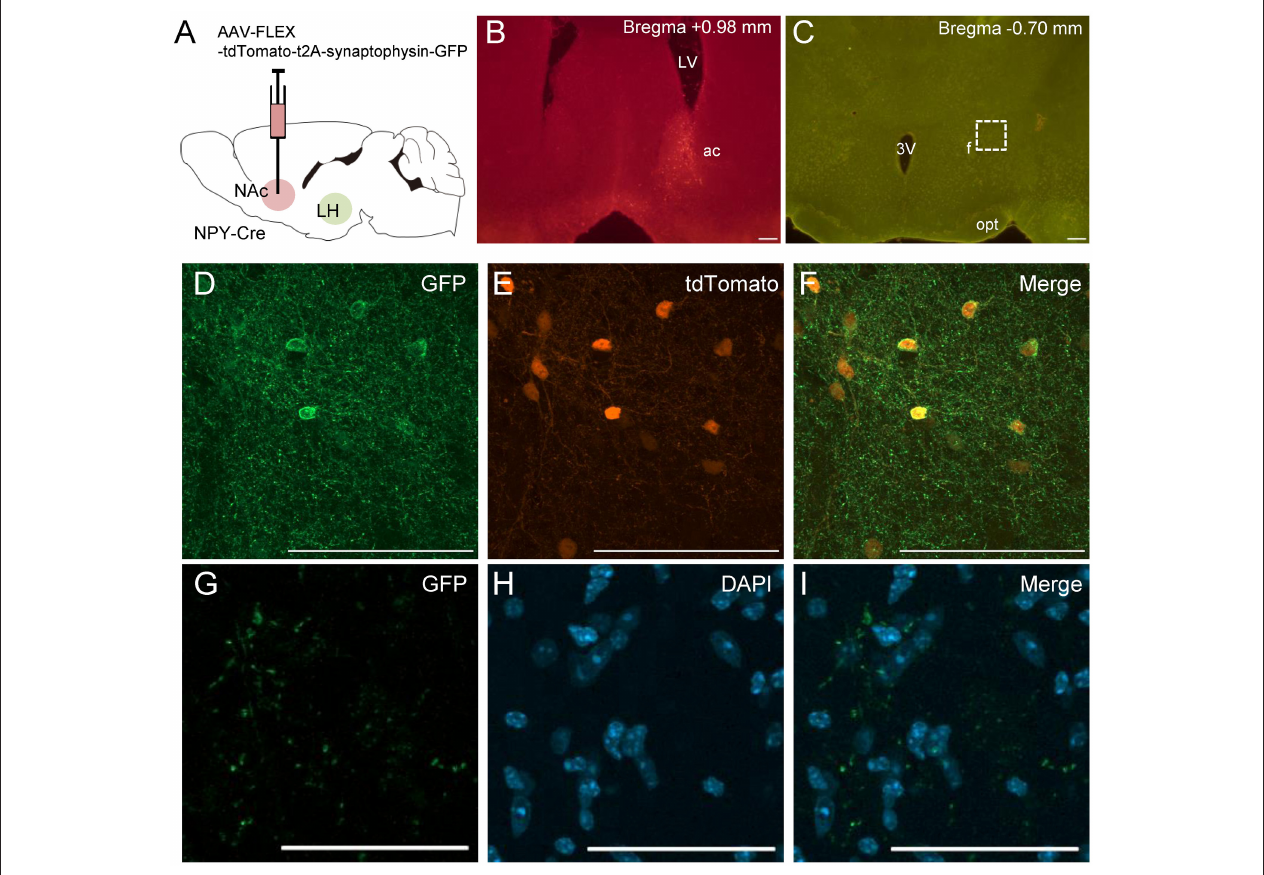
FIGURE 3 | Schematic illustration of AAV(dj)-FLEX-tdTomato-sypEGFP injection into the NAc in NPY-Cre mice (A) . Representative photograph of tdTomato-expressing cell bodies at the NAc injection site (B) , and of sypEGFP-expressing fibers in the LH (C) . Magnified fluorescence image of GFP (D) , tdTomato (E) , and merged (F) in the NAc. The regions in the white square box in C are magnified in G – I . Scale bars, 100 µ m ( B – F ) and 50 µ m ( G – I ). Numerical values in each photomicrographs show distances from bregma (mm). ac, anterior commissure; f, fornix; LV, lateral ventricle; opt, optic tract; 3v, third ventricle.